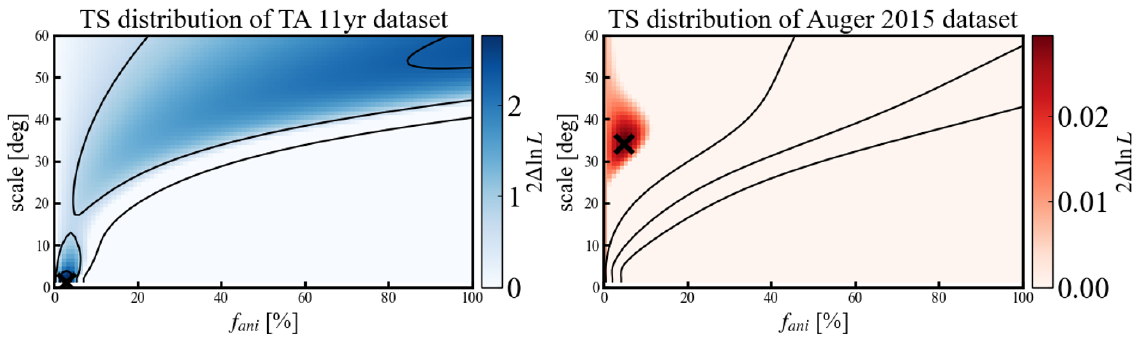
Figure 1. Distributions of the best-fit parameters for the 1000 mock event datasets in case of ( f true left panels show the results with ignorance of coherent deflection by GMF (Section 2.2). The right panels show the same but with consideration for GMF (Section 2.3). In both panels, true parameters ( f true contours indicate the 68% and 95% tile containment for all, north and south-sky datasets, respectively. The black cross, blue circle, and red triangle show the most frequent values for all, north and south-sky datasets, respectively. The distributions of best-fit parameters are smoothed with a kernel-Gaussian distribution. In the left panel, best-fit parameter ( f Auger as a black triangle.